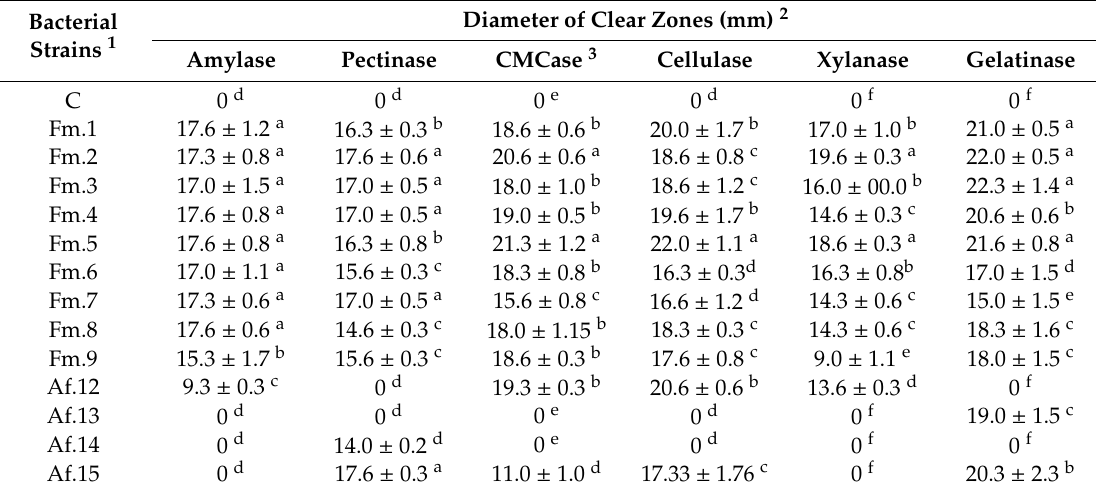
1 C: controls without bacterial inoculation. Identity of the bacterial isolates is available in Table 2. 2 Di ff erent letters between lines denote that mean values are significantly di ff erent ( p ≤ 0.05) by Tukey’s test, means ± Standard Error